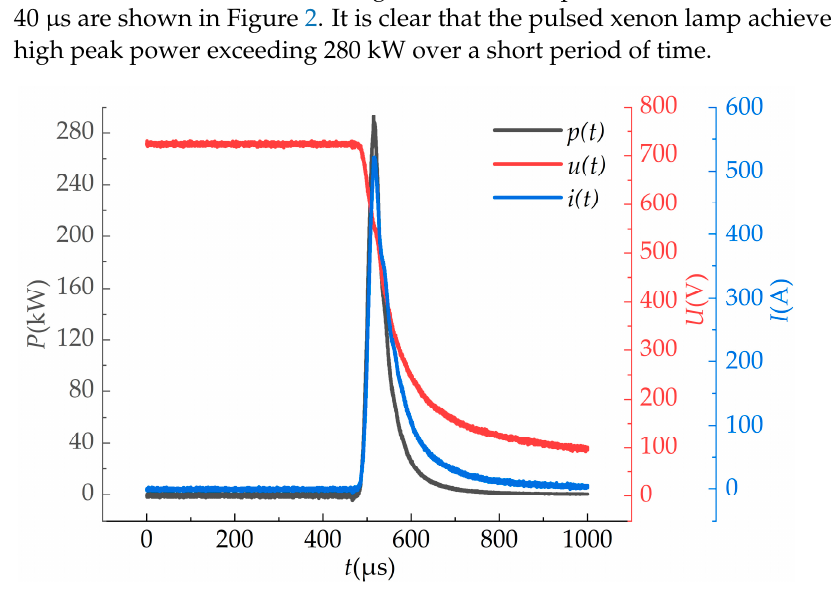
Figure 2. Oscillograms of voltage, current and power.